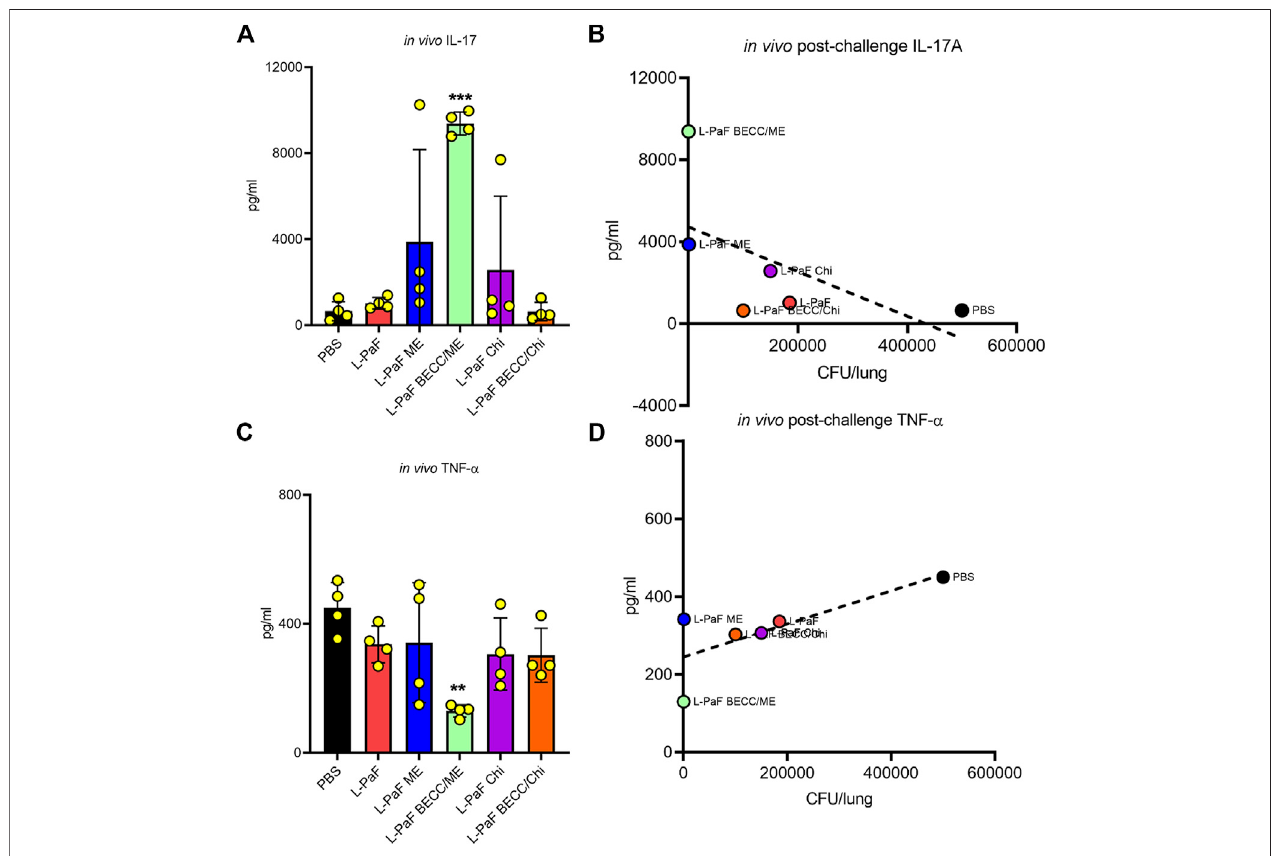
FIGURE8| The invivo post-challengecytokineswereassessedtoprovideapotentialimmunecorrelateofprotection.Theeffectsofpost-challengecytokineswere measuredin mice lung infected with the Paisolate mPa08-31. Lung cellsuspensions wereleft untreated for 48 h at 37 ° C.IL-17A (A) and TNF- α (C) weremeasured and plotted as actual values from individuals ± SD (n (cid:2) 4) in each group. Correlation of in vivo IL-17A (B) and in vivo TNF- α (D) were measured as described previously. Pearson ’ s r for these two graphs were − 0.5977 and 0.7565, respectively. Simple linear regressions were carried out, where R squared values were 0.3573 and 0.5722, respectively. ** p < 0.01, *** p <